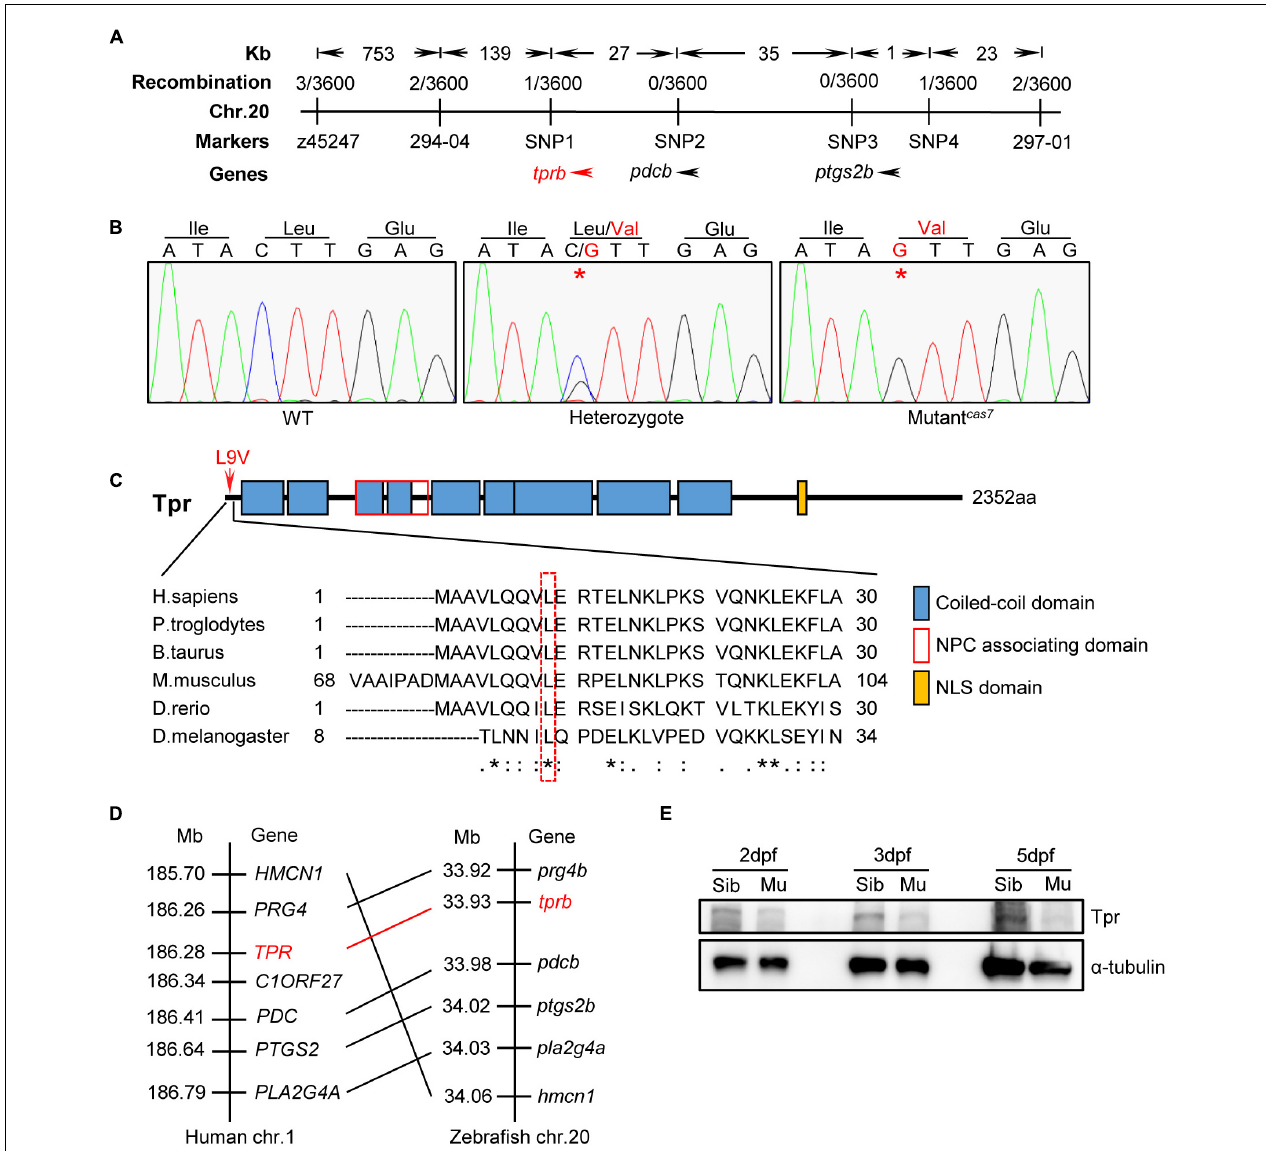
FIGURE 2 | Positional cloning of mutant cas 7 . (A) Genetic mapping of the cas7 region on chromosome 20. Bulk segregation analysis positioned cas7 mutation to Chr. 20. Fine mapping using SSLPs narrowed down the region between markers SNP1 and SNP4, including tprb and two other genes as indicated. (B) There is a C-to-G missense mutation in tprb gene in mutant cas 7 , which leads to leucine to valine (L9V) at ninth amino acid in Tpr protein. (C) The ninth amino acid leucine of Tpr is highly conserved from human to fruit fly (* marked). (D) Comparison of the gene syntenic relationship between zebrafish tprb and human TPR loci. Seven genes, including TPR , are located within a genomic region on human chromosome 1. (Right) Seven zebrafish homologs of these genes are listed according to their map positions on chromosome 20 (Ensembl website). Mb, mega base. (E) Western blotting images of Tpr protein in whole embryo lysates of sibling and mutant cas 7 embryos at the indicated time. All embryos were extracted for genomic DNA and genotyped by sequencing.